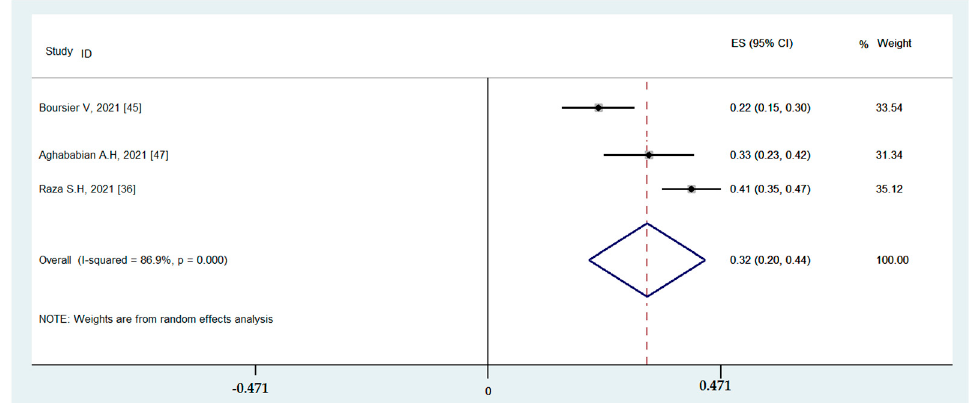
Figure 9. The forest plot displaying the estimated pooled Fisher’s z-score in the association between binge-watching and stress.